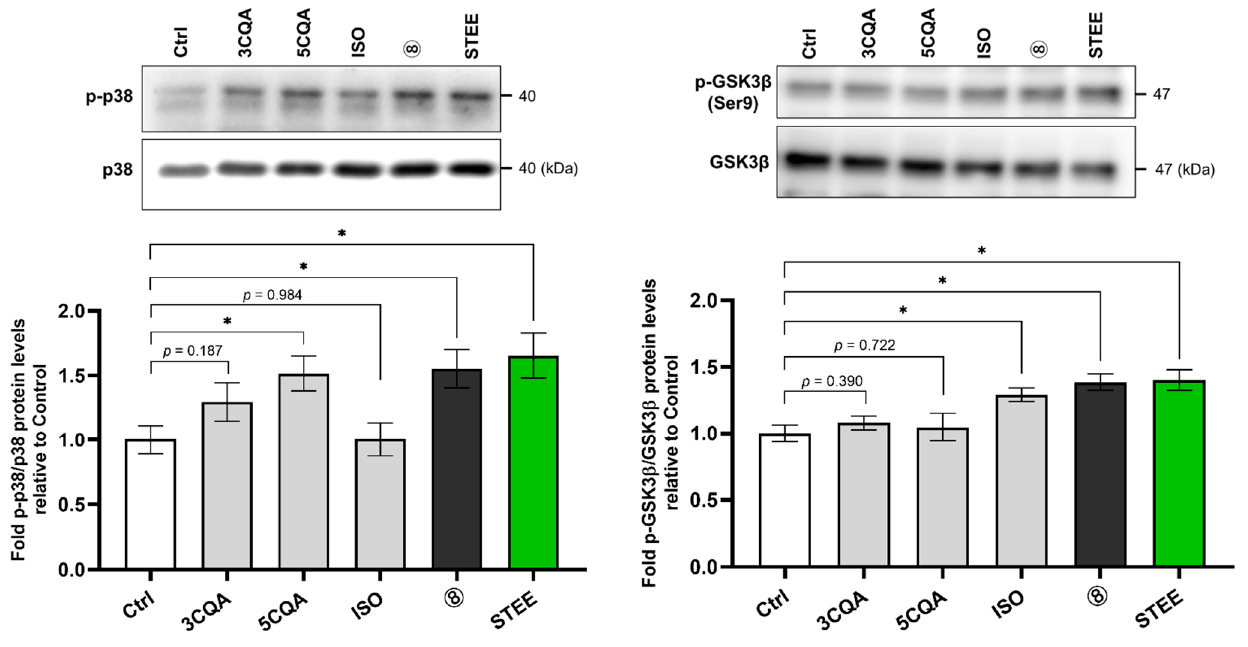
Figure 5. Polyphenolic constituents in STEE regulated p38 and GSK3 β activity in hNSC-derived immature astrocytes. Cells were treated with STEE and group 8’s compounds for 60 min. The amounts of p38, GSK3 β , p-p38, and p-GSK3 β expression in each cell lysate were detected by immunoblotting and quantified. The relative amounts are the mean ± SEM (n = 3) compared with the control. Student’s t -test for the comparisons: * p < 0.05. A description of the number for the treatment group is indicated in Table 1.